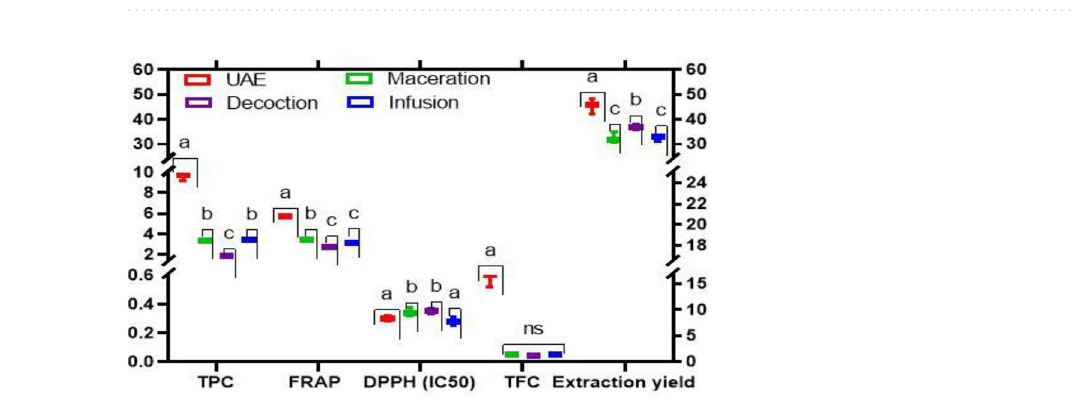
Table 5. Experimental values and predicted values of response variables at optimum extraction conditions. A ratio, B temperature, C time of extraction. Desirability: 0.89.